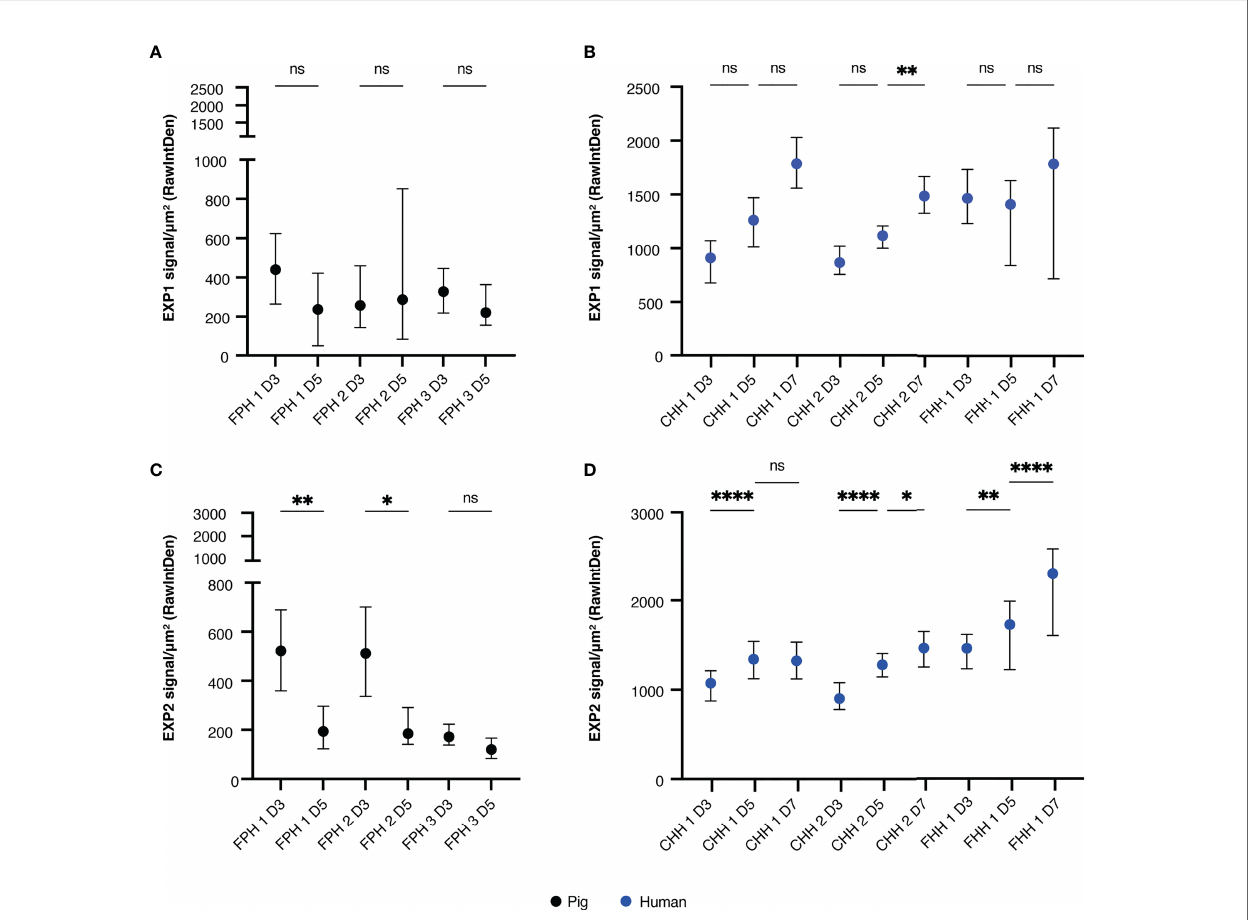
FIGURE 3 | Median EXP signal (±IQR) measured per schizont in porcine hepatocytes on day three and day fi ve post-invasion, corrected for noise and schizont size. All or up to seventy- fi ve schizonts were measured per technical replicate of three biological replicates. A two-way RM ANOVA was performed on the median of each replicate. (A) EXP1 signal in porcine hepatocytes. (B) EXP1 signal in human hepatocytes. (C) EXP2 signal in porcine hepatocytes. (D) EXP2 signal in human hepatocytes. For all panels, the total number of schizonts analyzed per condition is shown in Supplementary Table 2 . CHH, cryopreserved human hepatocytes; EXP, exported protein; FHH, fresh human hepatocytes; FPH, fresh porcine hepatocytes; NS, not signi fi cant. *P < 0.05; **P < 0.005; ****P <